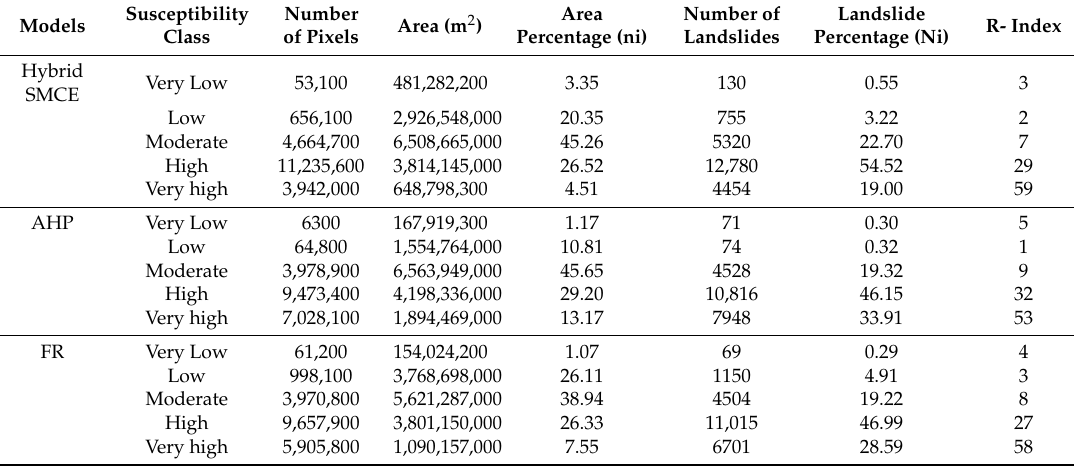
Table 6. Resulting R-indexes for the landslide susceptibility mappings (LSMs) based on AHP, FR and hybrid SMCE